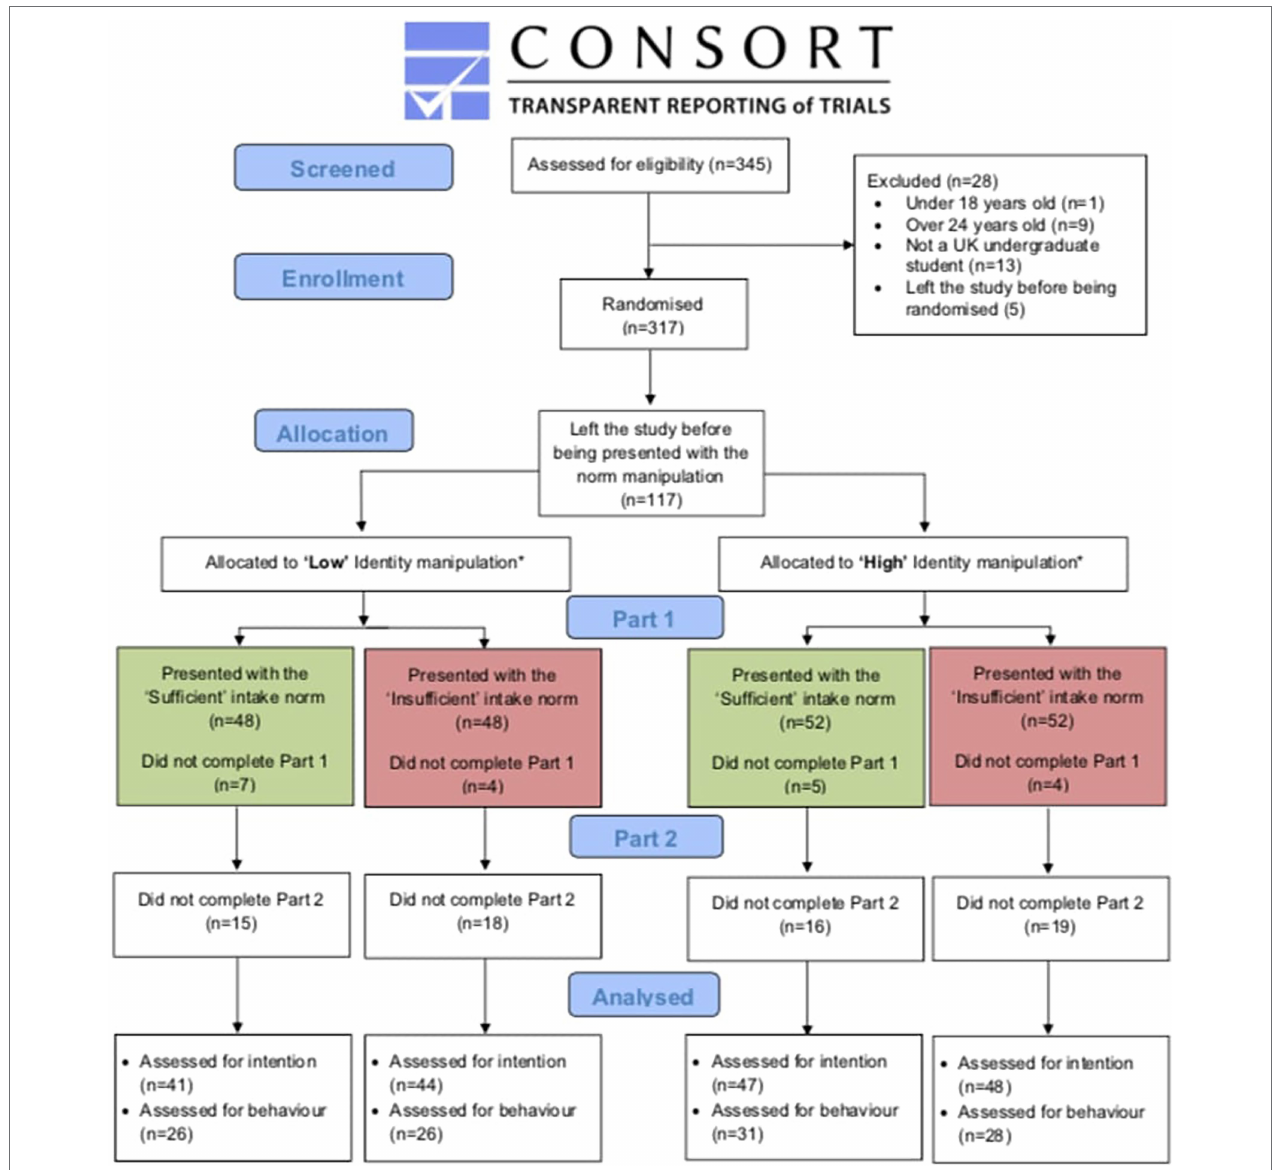
FIGURE 2 | Participant recruitment, allocation, and retention (CONSORT; Schultz et al., 2007). Asterisk indicates that out of the 317 individuals who were allocated to the “low” or “high” identification manipulation, 117 left the study before being presented with the infographics conveying the manipulated